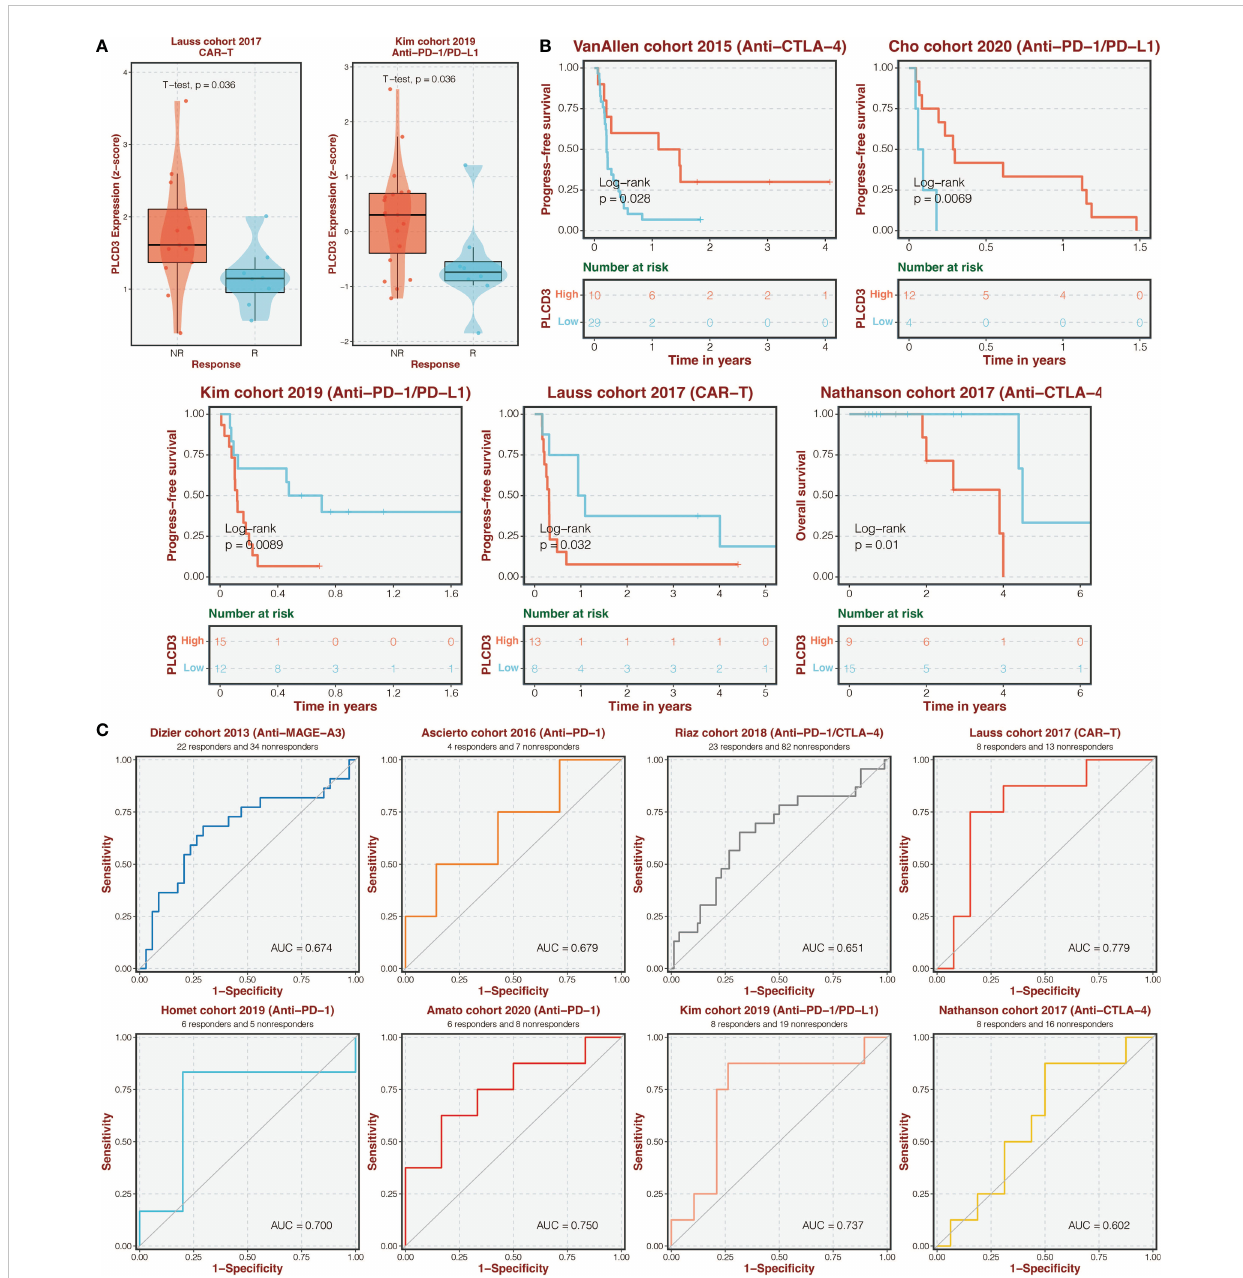
FIGURE 9 Immunotherapy prediction of PLCD3. (A) The expression of PLCD3 in responders and non-responders in immunotherapy cohorts. (B) Survival analysis was performed on the two groups regarding PLCD3 expression in immunotherapy cohorts. (C) The ROC curve of PLCD3 in predicting immunotherapy response in immunotherapy